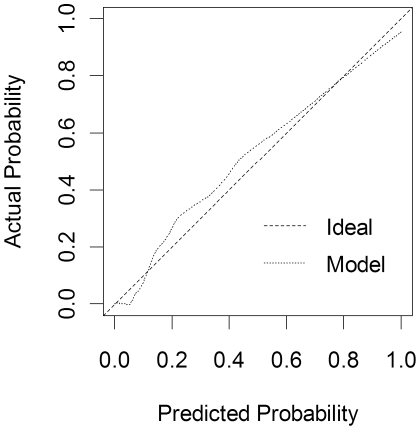
Calibration plot of the model predicting drain-related meningitis.The diagonal dashed line represents ideal prediction by the model, the pointed line predicted probabilities. Calibration, or the concordance between predicted and observed probability of infection, is adequate.